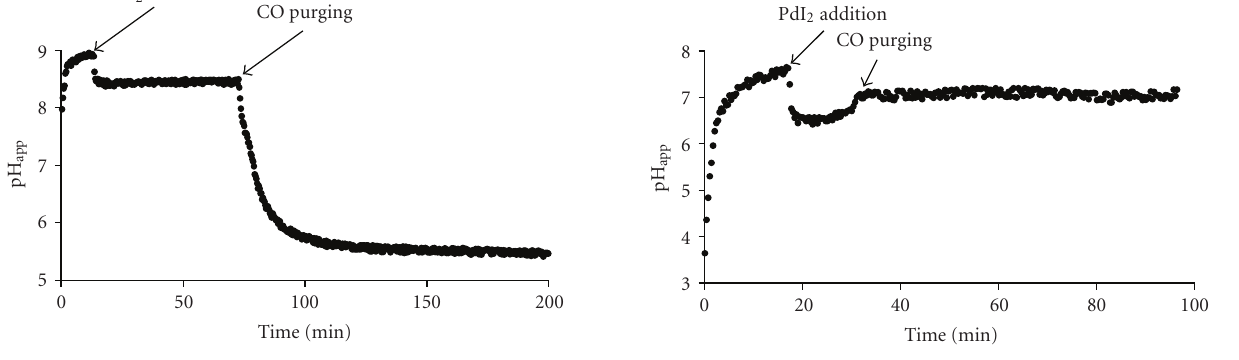
Figure 5: [KI] max = 6.4 · 10 − 1 mol/dm 3 ; [PdI 2 ] if all dissolved = 2.66 · 10 − 3 mol/dm 3 ; CO flow = 6mL/min; 25 mL of dry